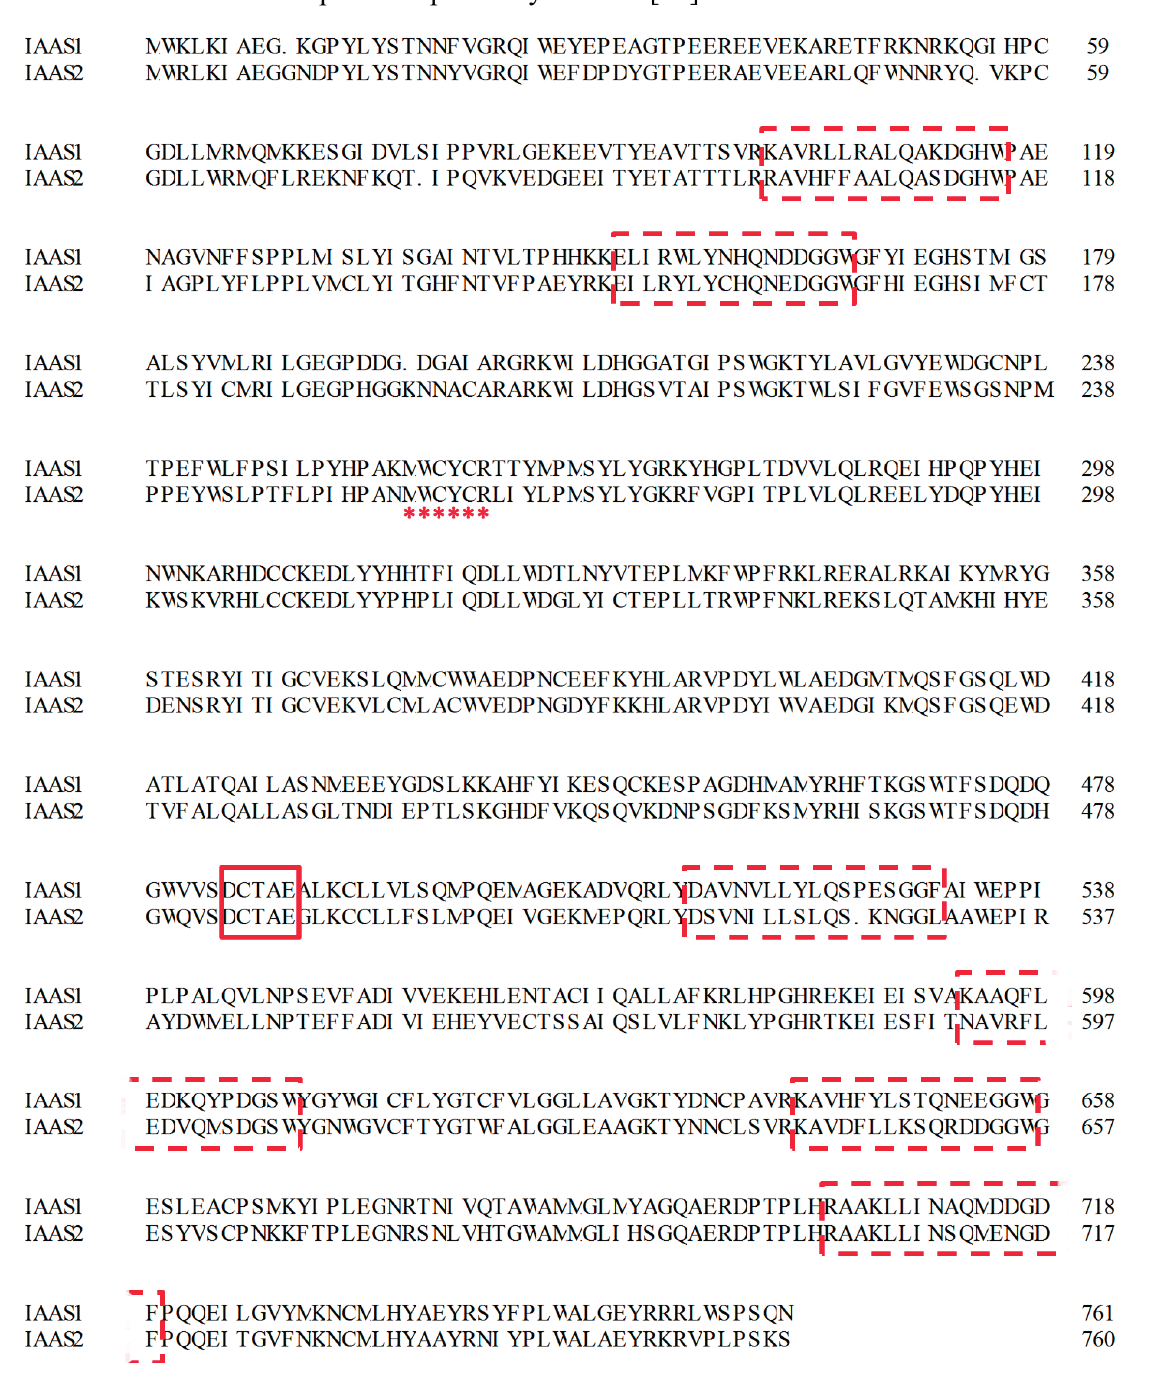
Figure 2, six QW motifs [(K/R)(G/A)XX(F/Y/W)(L/I/V)XXXQXXXGXW] were found in the protein sequences of both IaAS1 and IaAS2 , which are believed to be responsible for strengthening the structure of the enzyme and stabilising its carbocation intermediates, as well as a DCTAE motif, which might play an important role in substrate binding [20,21]. Furthermore, a MWCYCR motif was identified that is believed to be related to the product specificity of BAS [22].